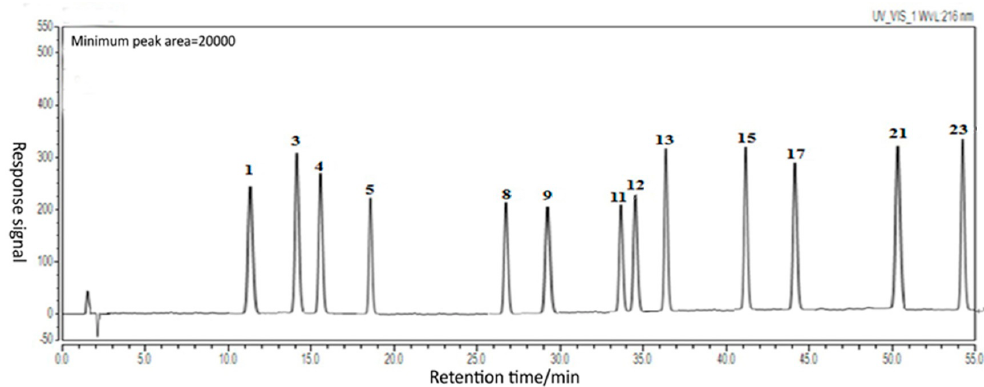
Figure 4. Hierarchical cluster analysis of S. chinensis.